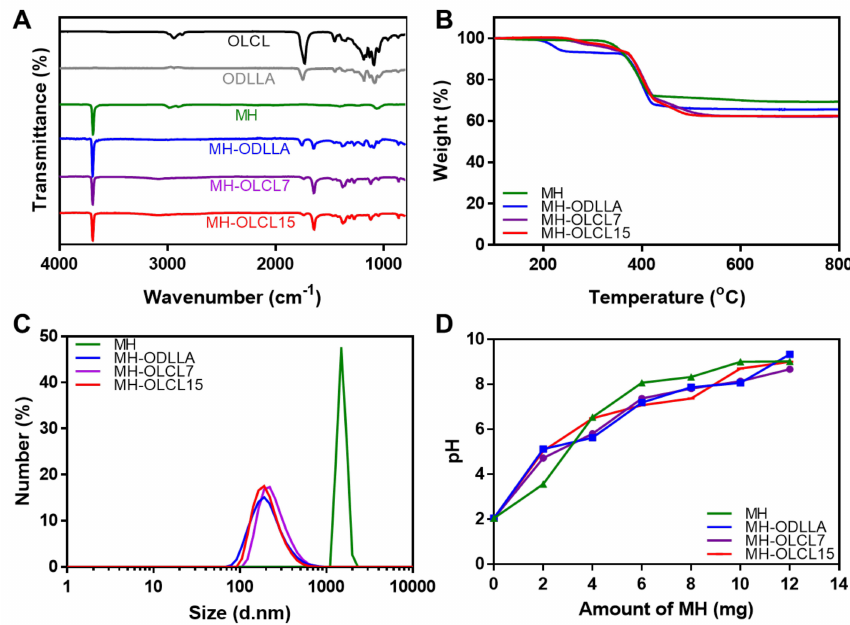
Figure 2. Surface-modified MH characterization. ( A ) ATR-FTIR spectra, ( B ) TGA thermo- grams, ( C ) size distributions, and ( D ) pH titrations of MH, MH-ODLLA, MH-OLCL7, and MH-OLCL15